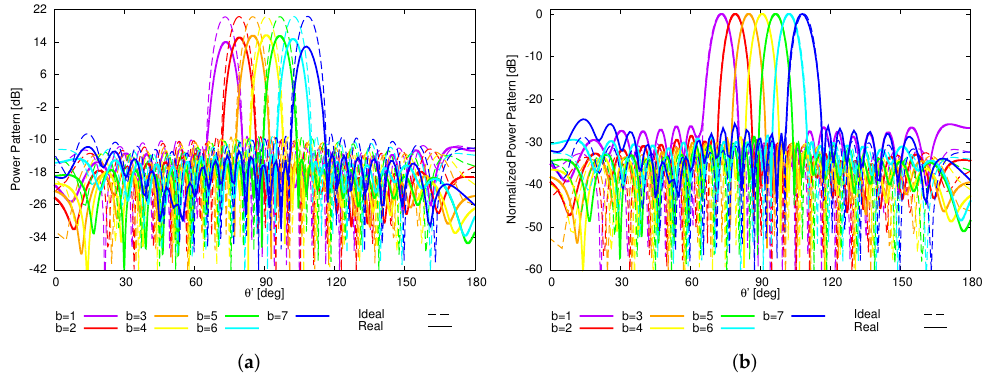
Figure 8. Numerical Assessment ( M = 16, d = λ B radiated power patterns for the ideal and real 16-element sparse linear